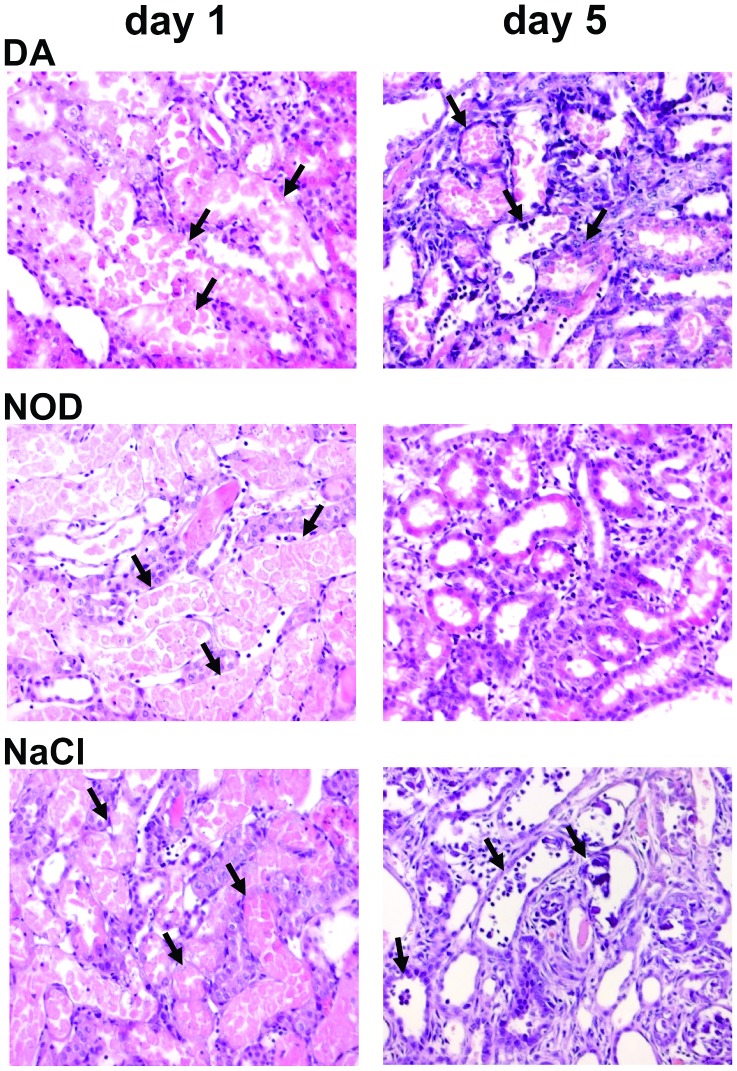
Histology (H&E stain) of proximal tubule segment S3 (pars recta) on day 1 and day 5.On day 1 there are no significant differences between the groups (left H&E stains). Cellular swelling, tubular epithelial necrosis and apoptosis are detectable at segment S3 at the pars recta of proximal tubules in all groups (see arrows). At day 5 (right H&E stains) in NaCl and DA groups revealed cellular debris in the tubular lumen, apoptosis, necrosis, shedding of the proximal tubule brush border with intraluminal calcifications and desquamation of cells (see arrows). In contrast in the NOD group proximal tubules show marginal calcifications and less destruction of epithelial cell lining with marked repopulation of tubular epithelial cells.